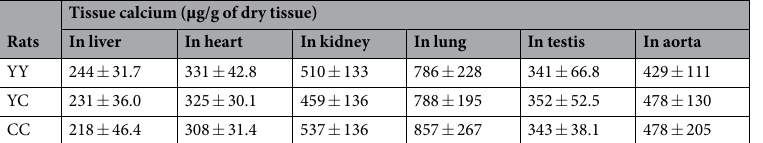
Table 2. Tissue calcium concentration of 1 year old-YY, YC and CC rats fed with standard diet. Results are expressed as mean ± SD. n = 9 for YY and CC groups, n = 8 for YC